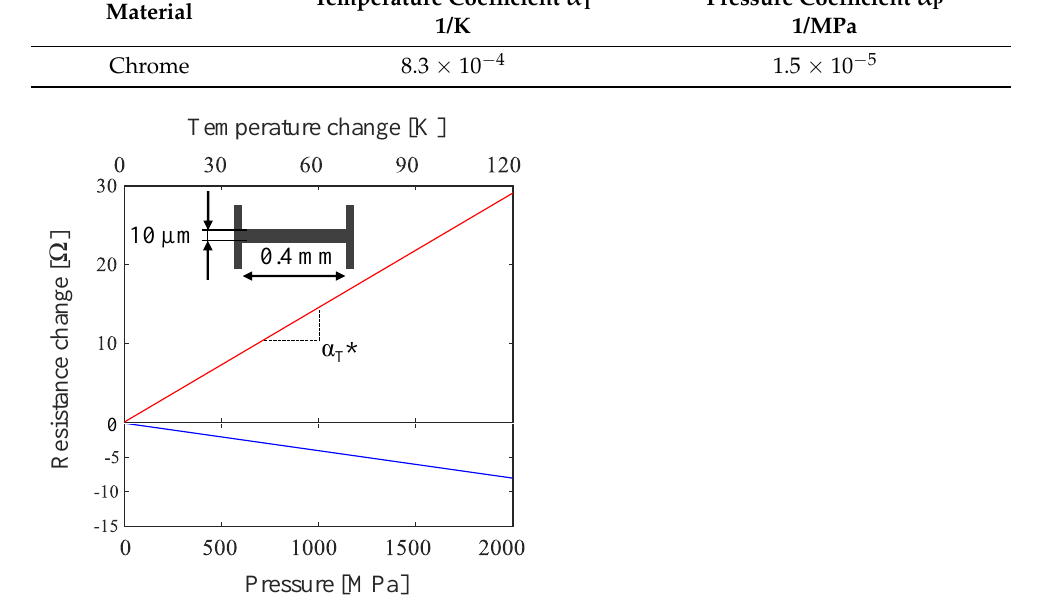
Figure 3. Temperature (red line) and pressure dependency (blue line) of a line sensor.